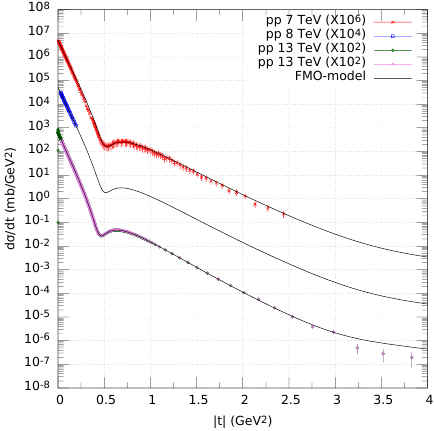
Figure 4. Di ff erential pp cross sections at LHC energies in FMO